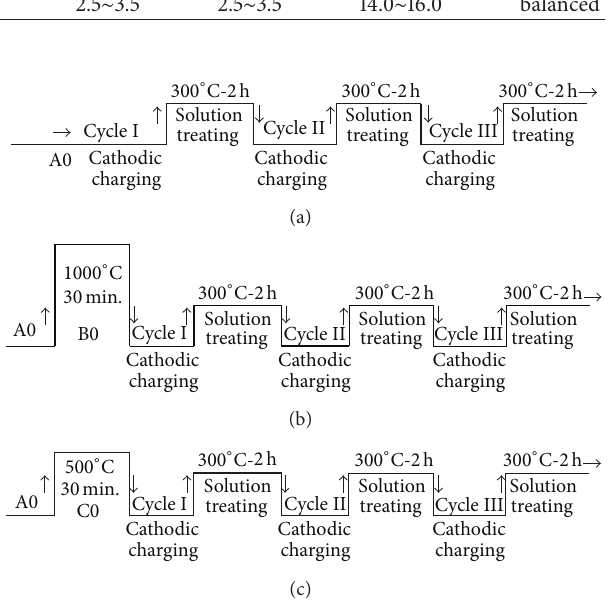
Figure 1: Schematic diagrams of the designed cyclic hydrogenation- solid solution treatment for (a) A0, (b) B0, and (c) C0 sheets.